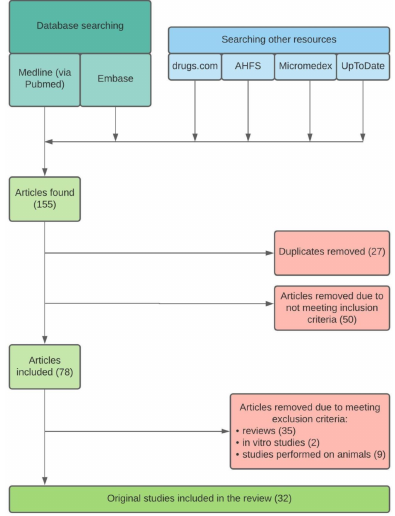
Figure 1. Searching strategy flowchart.